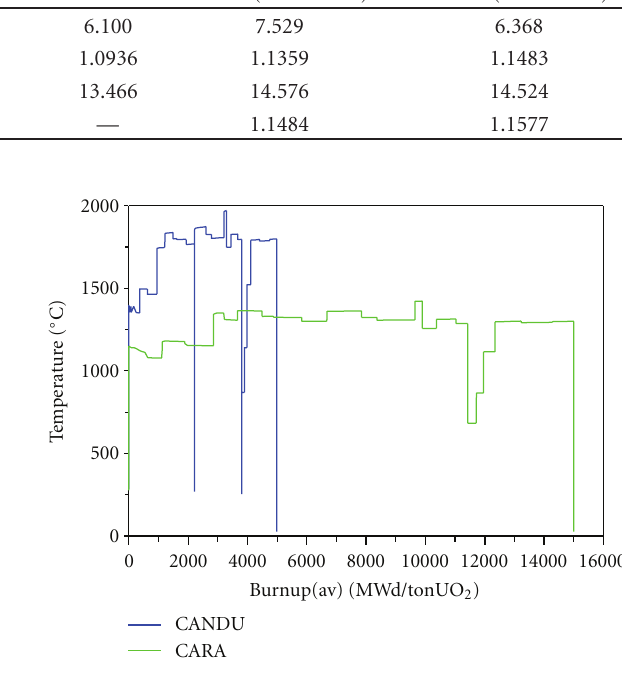
Table 14: WIMS results, neutronic di ff erences between CARA and CANDU and Atucha I. Characteristic